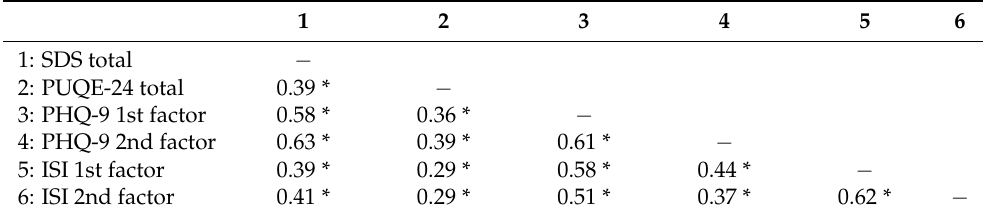
Table 4. Correlation of the SDS, PUQE-24, PHQ-9 subscales, and ISI subscales.